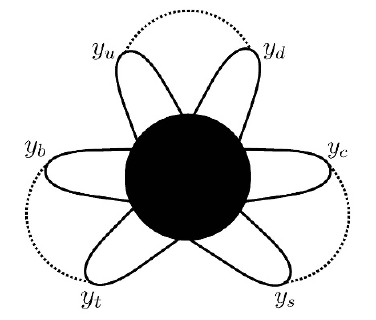
Figure 3 . Instanton vacuum diagram arising from closing the SM fermion legs with Higgs